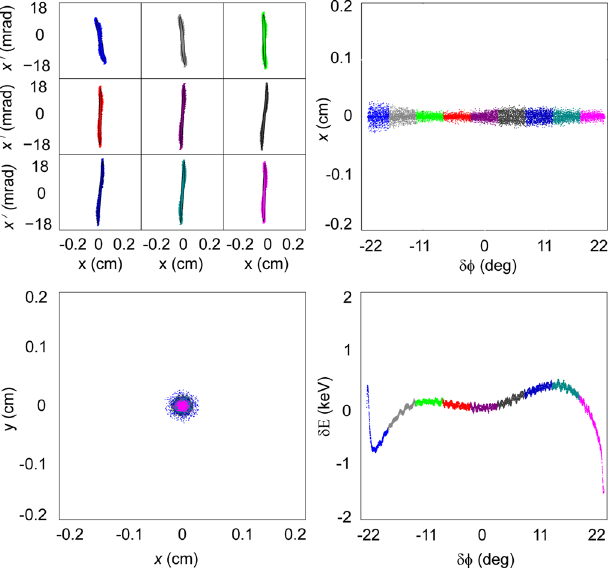
FIG. 27. The bunch phase-space at the output of the 3rd harmonic cavity. Top left: transverse phase-space of slices, top-right: transverse position of electrons vs rf phase, bottom left: transverse distribution of particles; bottom right: longitudinal phase-space.